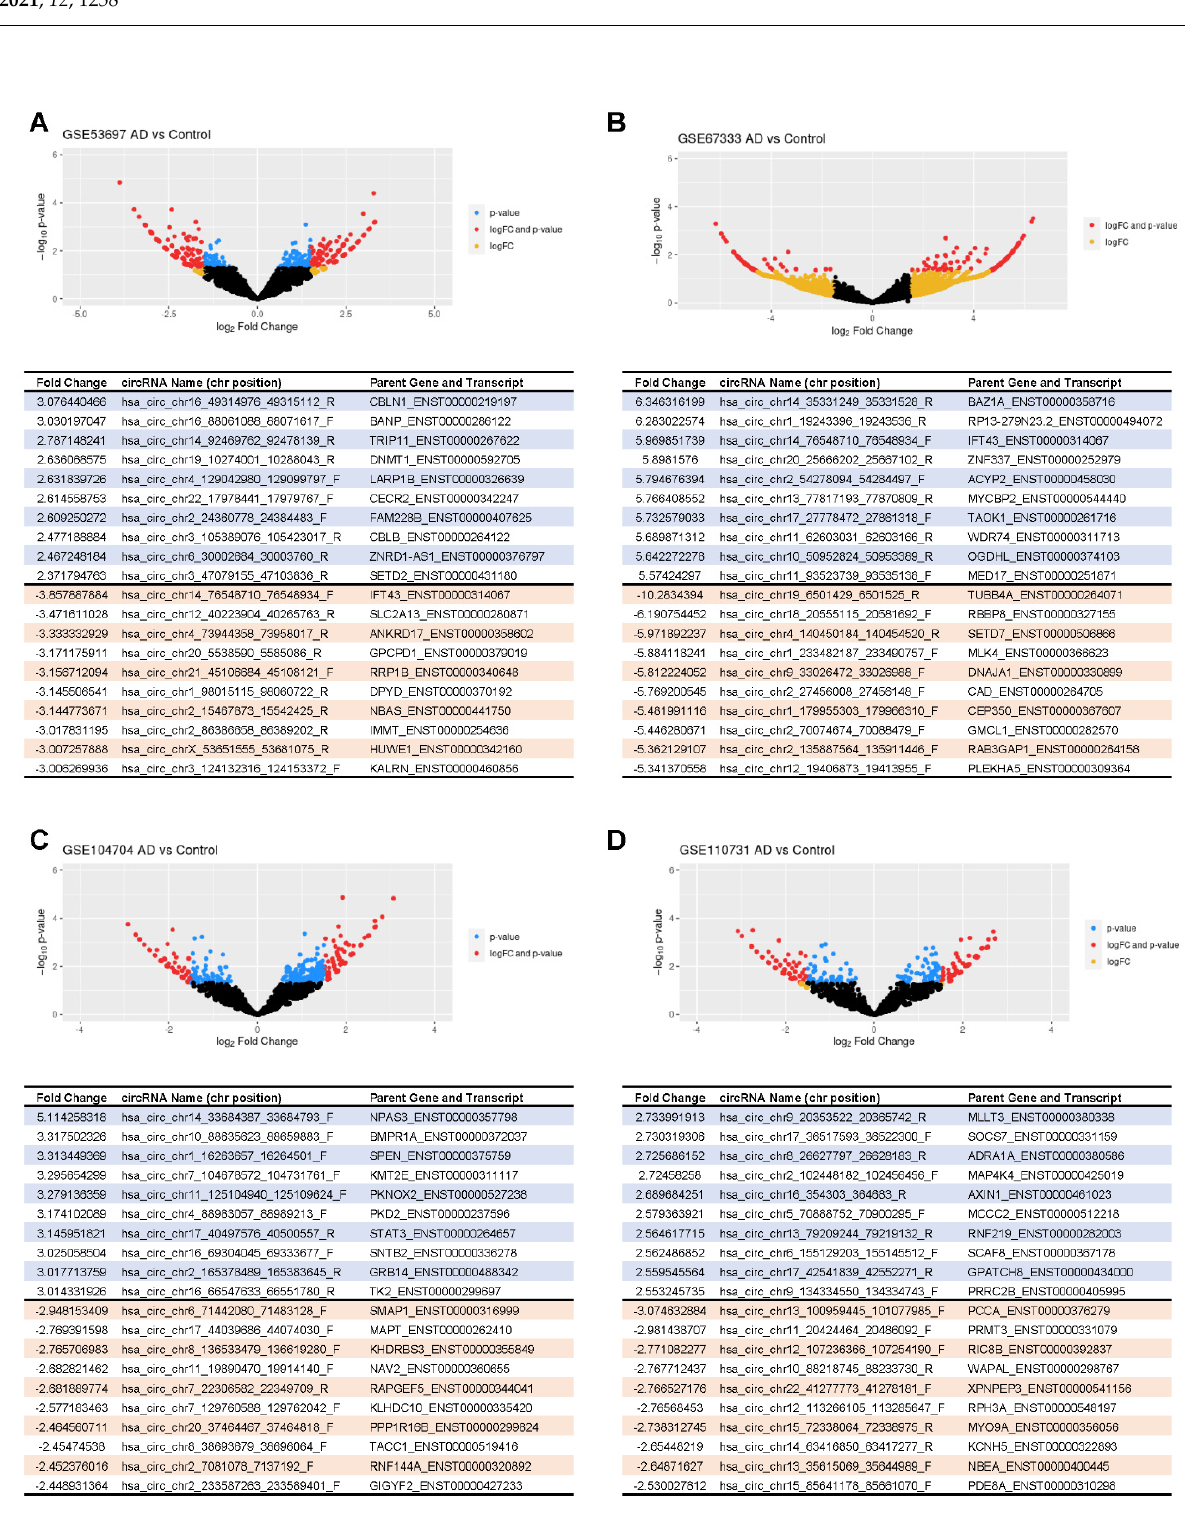
Figure 2. Differentially abundant circRNAs in brain datasets. Volcano plot representations of the four studies using brain tissue samples included in this analysis: frontal lobe (GSE53697) ( A ), hippocampus (GSE67333) ( B ), temporal lobe (GSE104704) ( C ), and frontal lobe (GSE110731) ( D ). Each point on these plots represents a specific circRNA with log fold-change (logFC) on the x-axis and − log 10 ( p -value) on the y-axis when comparing AD samples with normal control individuals. The points in yellow represent circRNAs with only logFC greater than 1.5 (threefold higher), the points in blue represent circRNAs with only p -value < 0.05 (i.e., − log 10 ( p -value) > 1.3), and the points in red represent circRNAs both logFC > 1.5 (threefold lower) and p -value < 0.05. Below each volcano plot is a list of the top 10 most highly abundant (blue) and top 10 least abundant (orange) when comparing circRNAs in brain from AD individuals to cognitively normal control individuals.